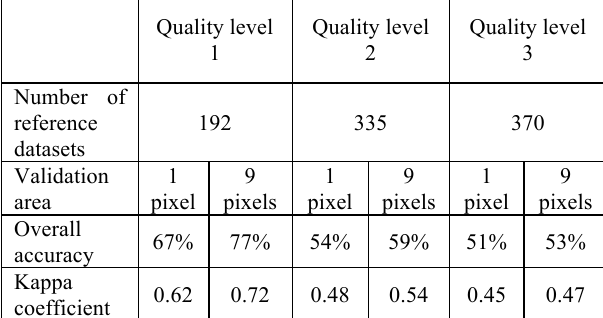
Table 5. The validation results of the MODIS IGBP global land cover products with quality-level reference data.